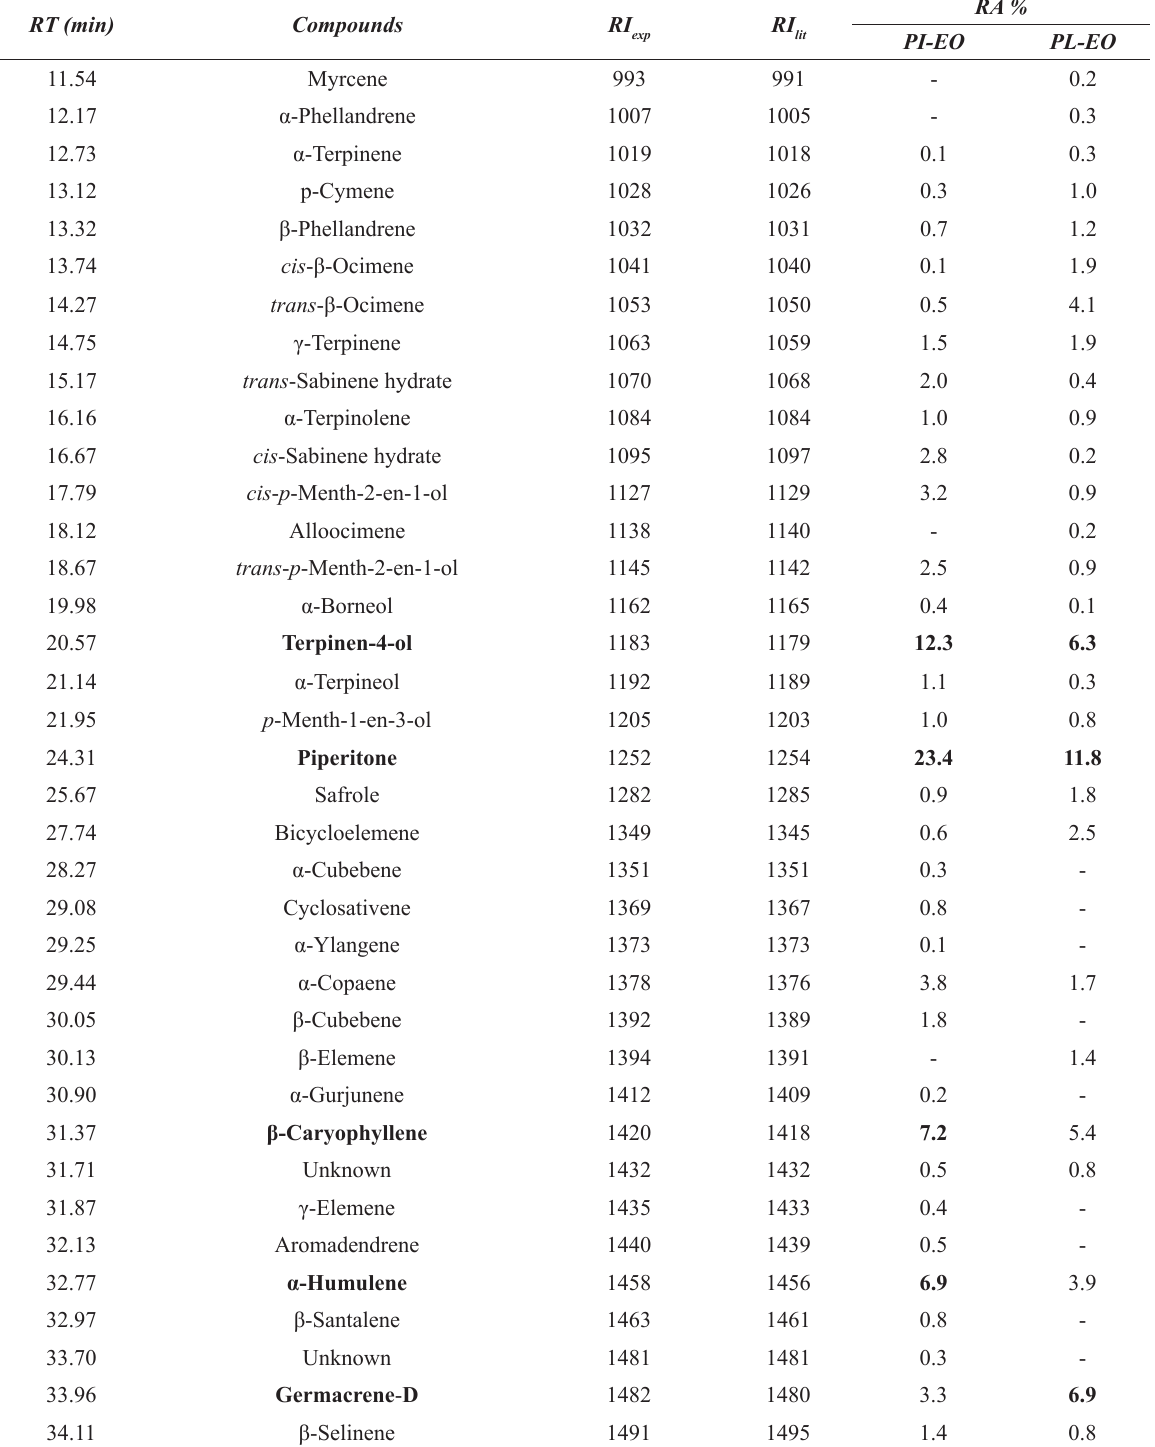
Chemical composition of essential oils from P. aduncum inflorescences (PI-EO) and leaves (PL-EO) collected in Rio Verde, Goiás,